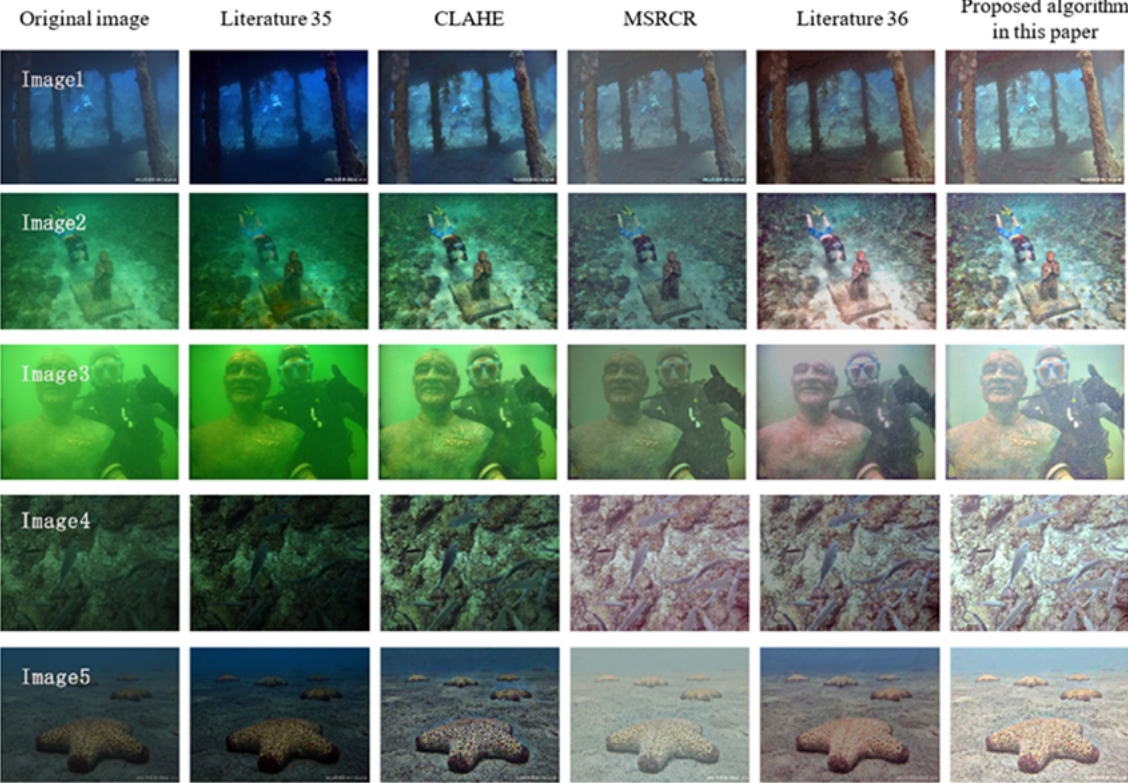
Figure 3. Comparison of experimental results with different